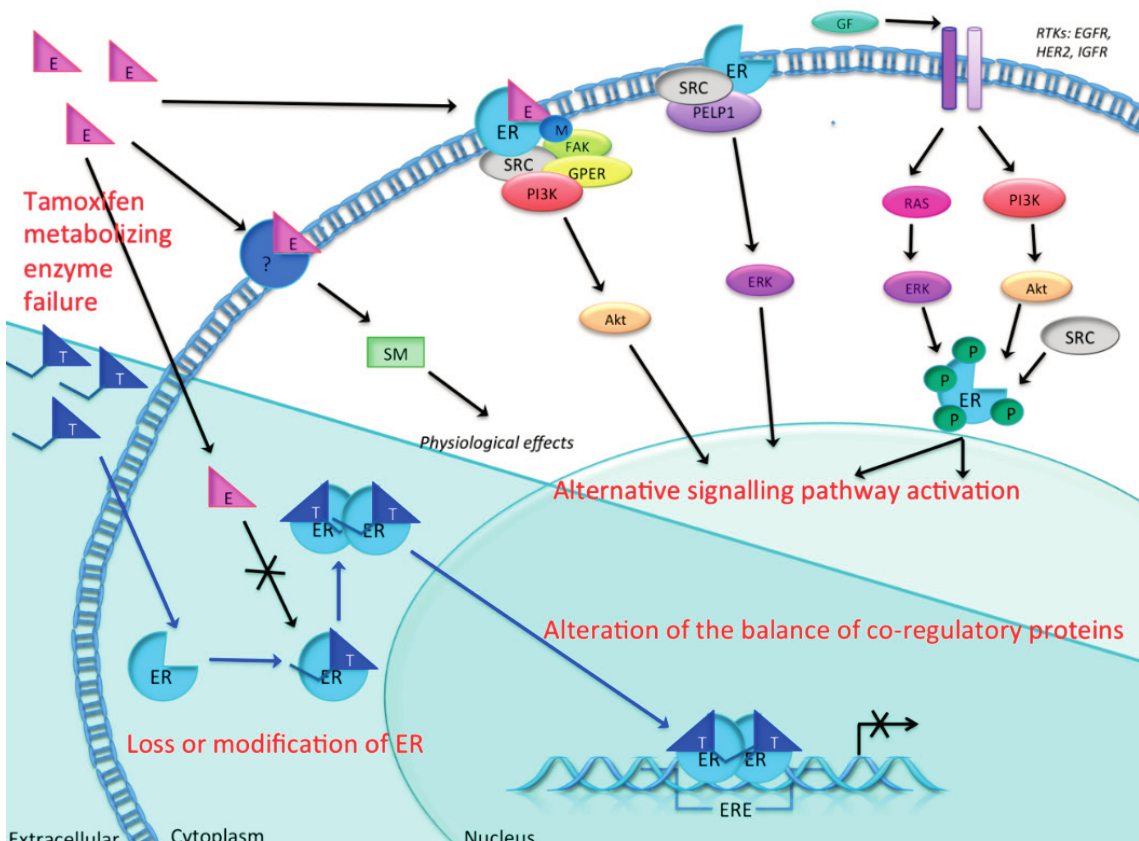
Figure 3. The tamoxifen pathway and possible mechanisms of endocrine resistance in breast cancer cells. Prior to entering the breast cancer cell, tamoxifen (T) is metabolized